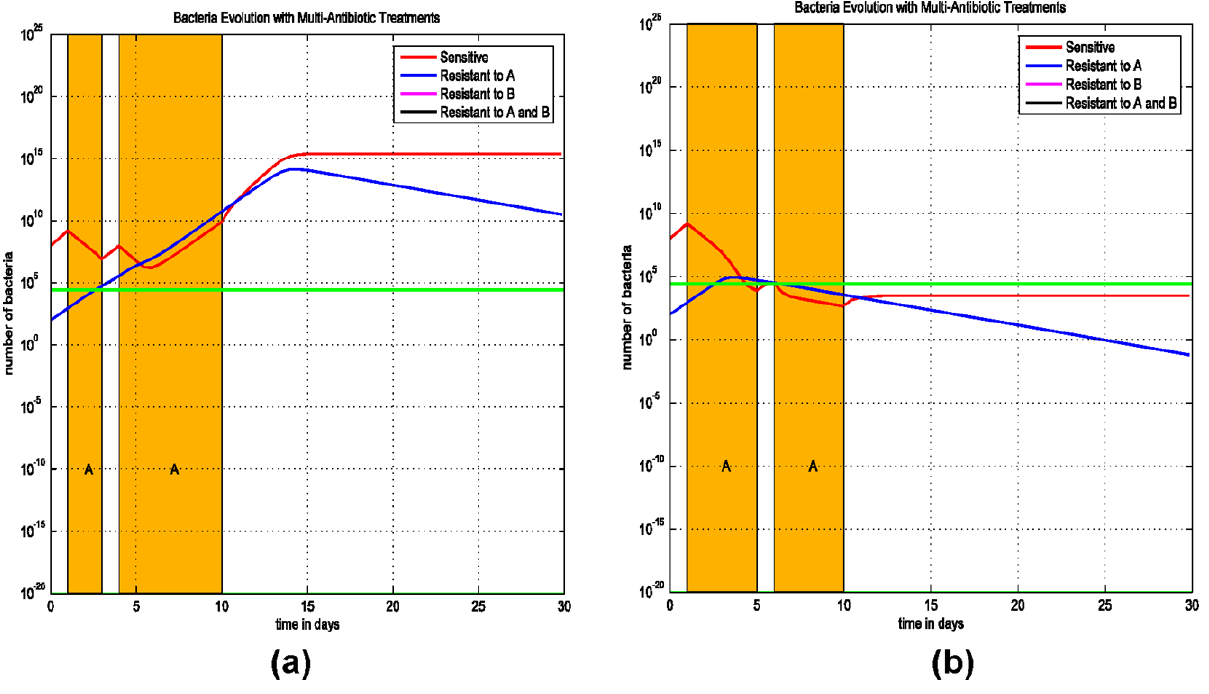
Figure 3. Simulations of Model (2) on the interruption of treatment and infection progression. (a) Treatment is interrupted for 1 day at day 3 and continues for the rest of the 9-day therapy. The bacterial load does not change much and increases afterward, the infection is progressive. (b) Treatment is interrupted for 1 day at day 5 and continues for the rest of the 9-day therapy. The bacterial load decreases steadily and the infection can be prevented.